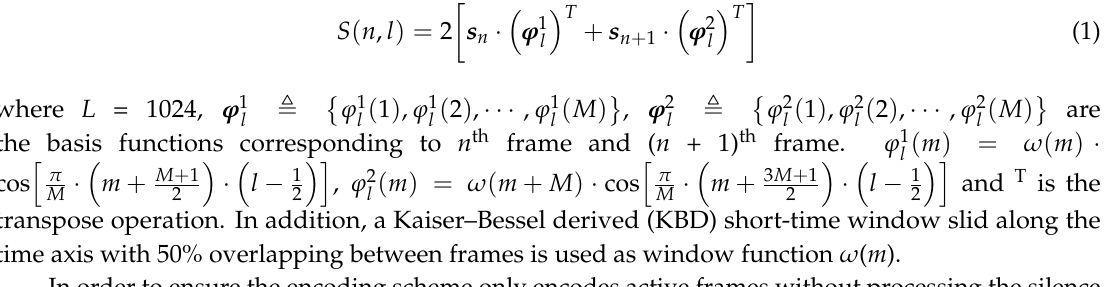
Figure 1. The block diagram for the proposed compression framework. (MDCT, Modified Discrete Cosine Transform; IMDCT, Inverse Modified Discrete Cosine Transform; NPTF, Number of Preserved Time-Frequency Bins; SQVH, Scalar Quantized Vector Huffman Coding; TF, Time-Frequency).